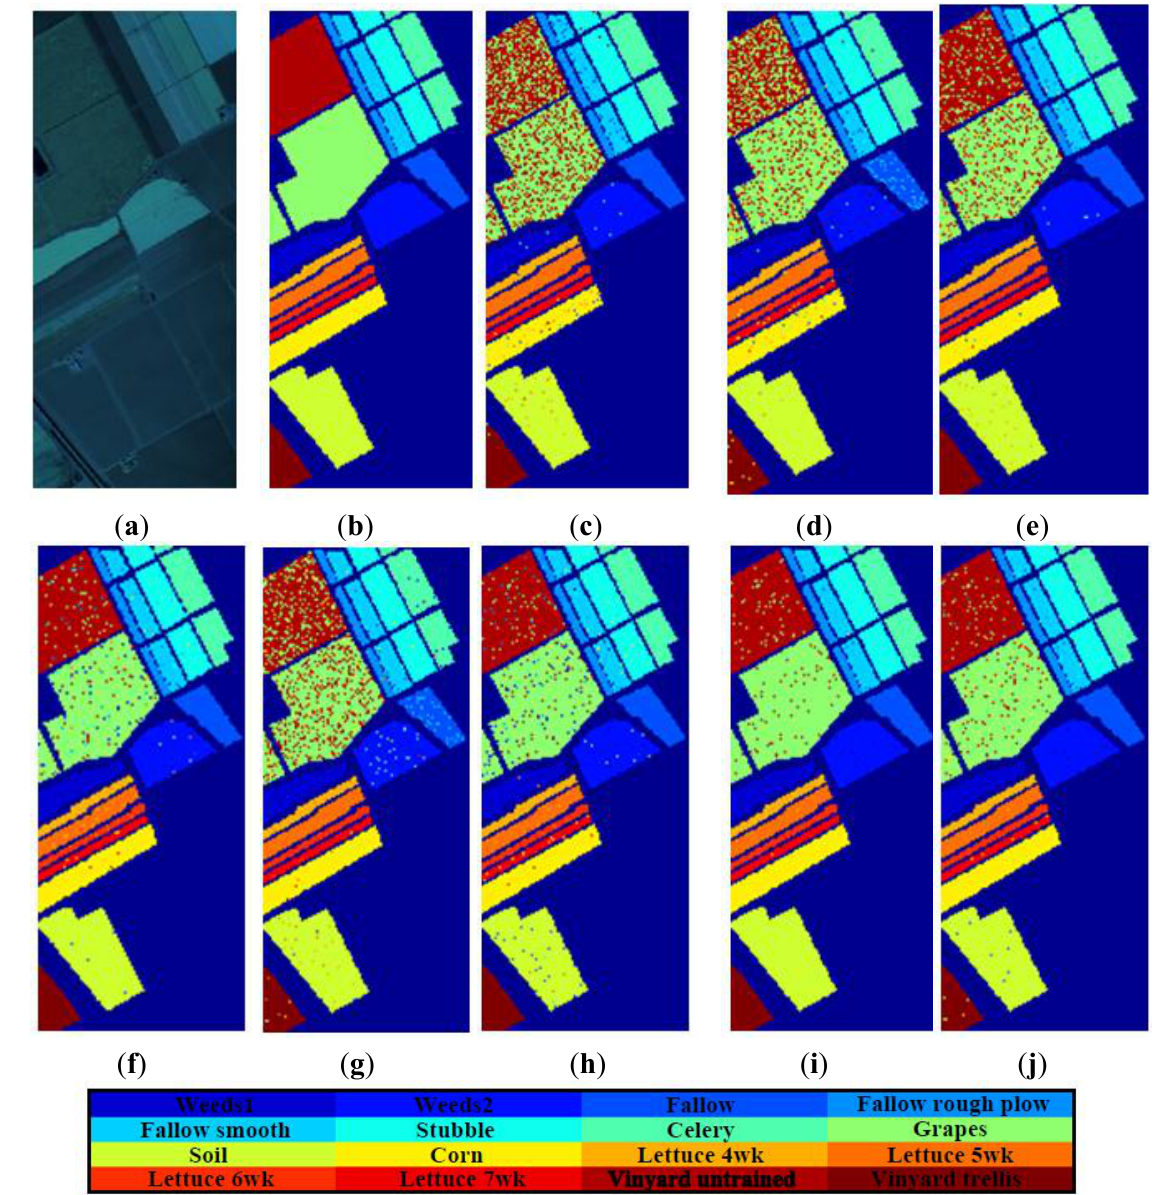
Figure 9. Thematic maps for the Salinas dataset with 30 training samples per class; ( a ) Pseudo-color Image; ( b ) Ground truth Map; ( c ) NRS; ( d ) SRC; ( e ) NRS + Gabor; ( f ) NRS + LBP; ( g ) SRC + Gabor ( h ) SRC + LBP; ( i ) RF-NRS; ( j )